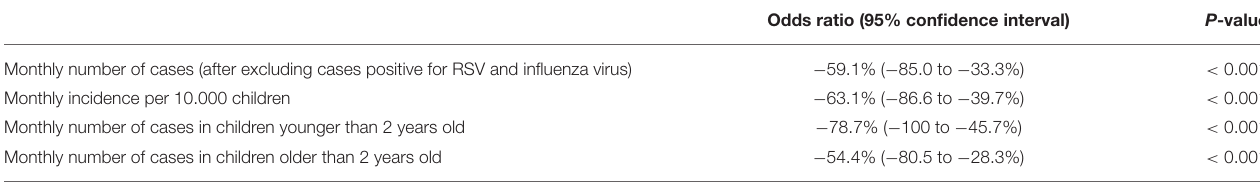
Odds ratio (95% confidence interval) P -value